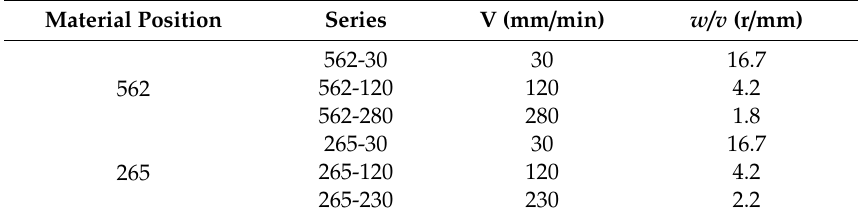
Table 3. Welding parameters used to make the three dissimilar T-joints.